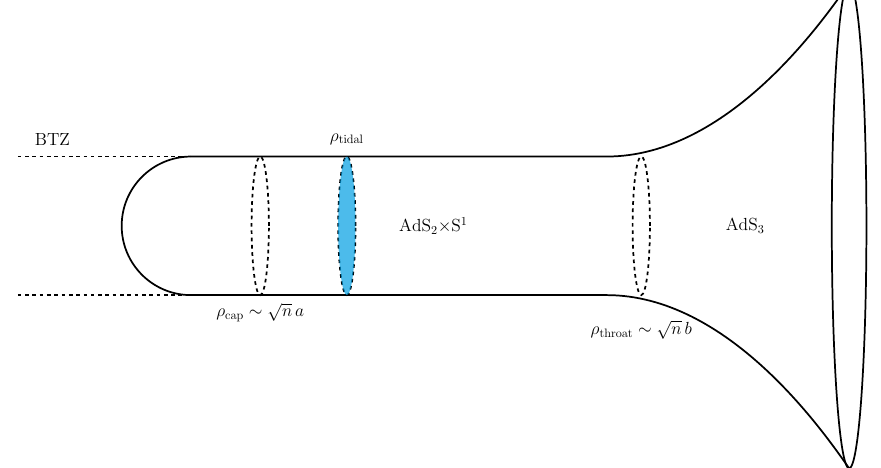
Figure 4. Schematic representation of a spatial slice of the superstrata geometry described by the metric (4.1). Each point in the picture corresponds to an S 3 in the six-dimensional geometry. Coming in from infinity, there is an asymptotic AdS 3 region, followed by an AdS 1 × S 3 3 × S 2 × S throat region which then ends in a smooth cap region. For geodesics falling in from a large radius in the asymptotic region, the tidal forces are in danger of invalidating the geodesic approximation at a radius ρ in the throat tidal